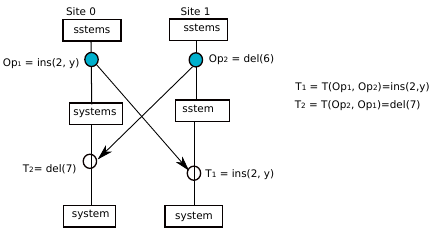
Figure 2. Integrate operation in OT algorithms